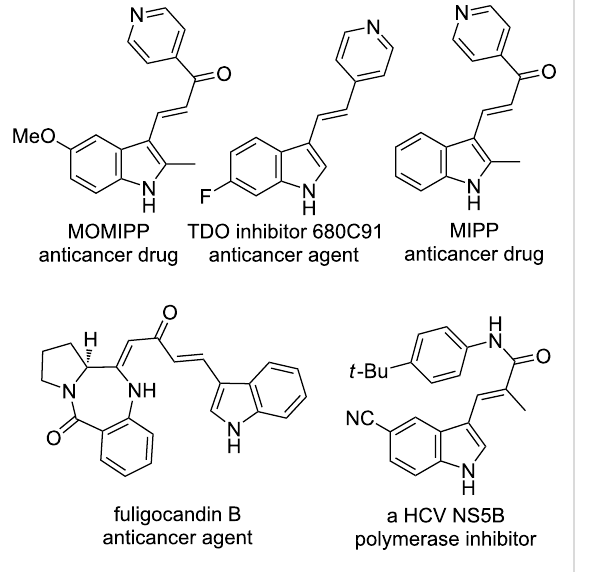
Figure 1: Biologically and medicinally important 3-alkenylindoles.